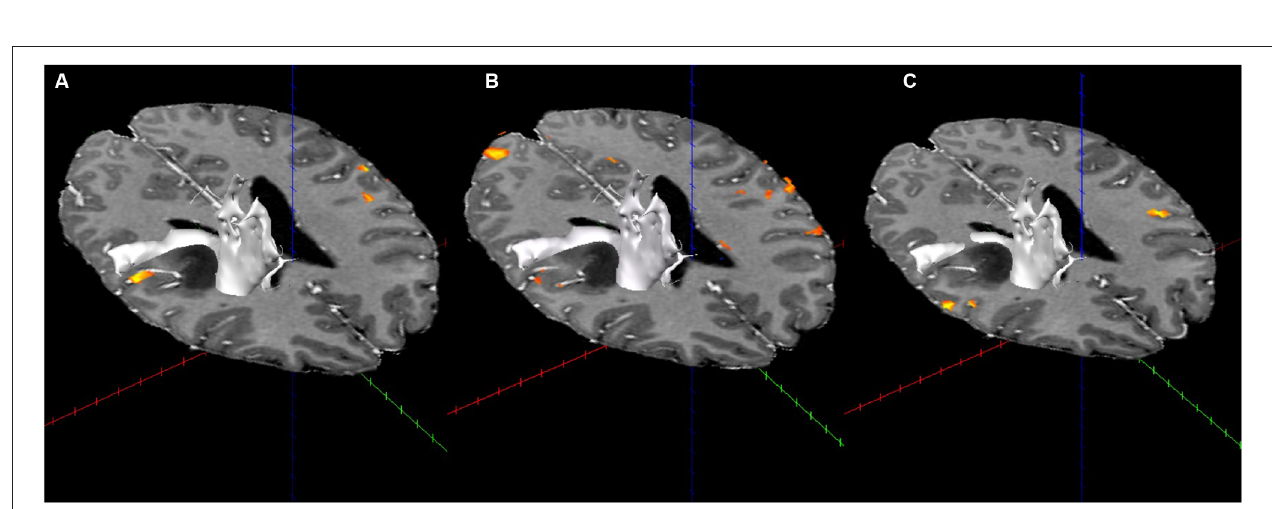
FIGURE 4 | Combined fMRI and DTI (in white; using Brain Voyager QX Software) for the three fMRI tasks. (A) Activation with tractography in the arms rubbing on scanner task. (B) Activation with tractography in the hands rubbing on scanner task. (C) Activation with tractography in the lip-licking